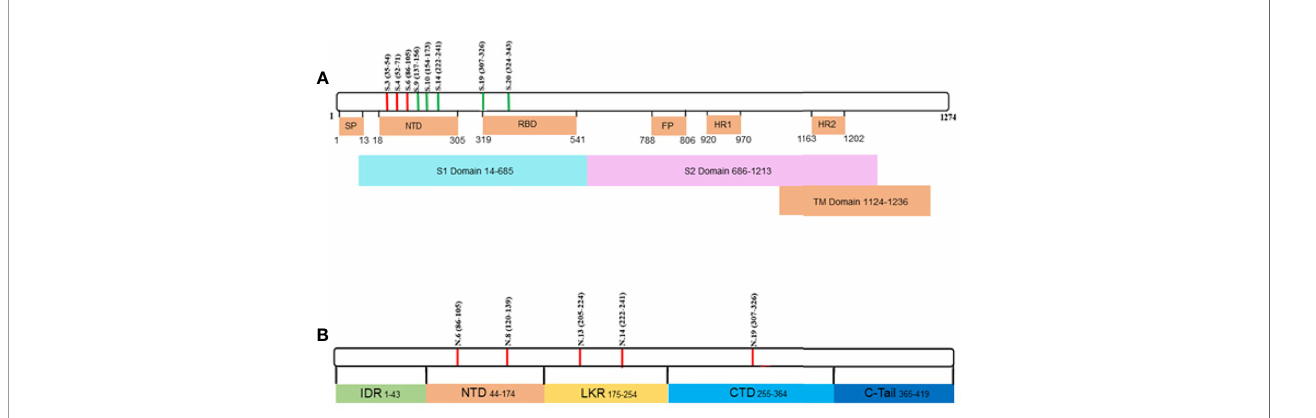
FIGURE 2 | Schematic presentation of S and N protein peptides location reacting with non-fatal and fatal COVID-19. (A) Location of S protein peptides reacting with non-fatal and fatal COVID-19 IgM; (B) Location of N protein peptides reacting with fatal COVID-19 IgM. Red color – peptides reacting with fatal COVID-19 IgM; Green color – peptides reacting with non-fatal COVID-19 IgM. S1, Spike 1; S2, Spike 2; TM, Transmembrane; SP, Signal Peptide; NTD, N-terminal Domain; RBD, Receptor Binding Domain; FP, Fusion Peptide; HR1, Heptad Repeat 1; HR2, Heptad Repeat 2; IDR, Intrinsically Disordered Region; NDT, N-terminal Domain; LKR, Linked Region; CTD, C-terminal